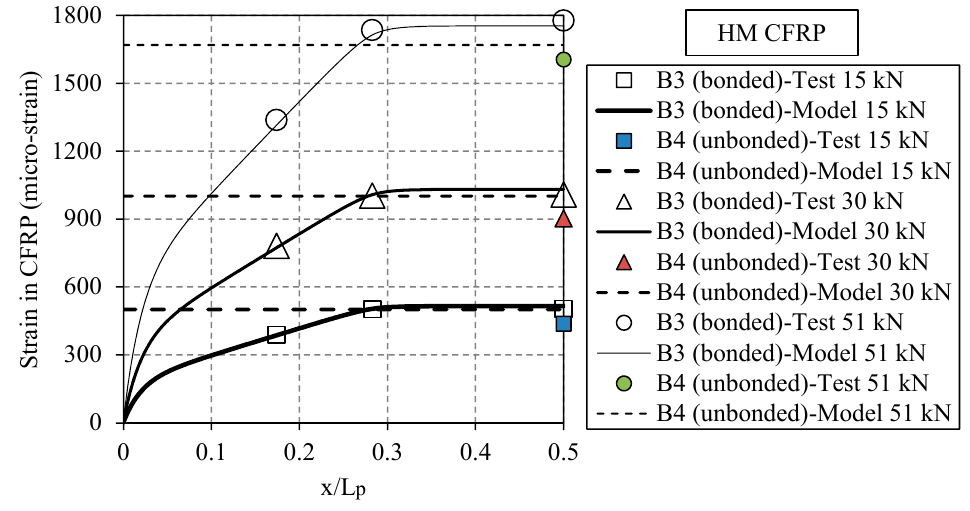
Figure 11. The measured and calculated strains along the CFRP plates for the specimens strengthened with bonded and un-bonded HM CFRP plates (i.e., B3 and B4, respectively).